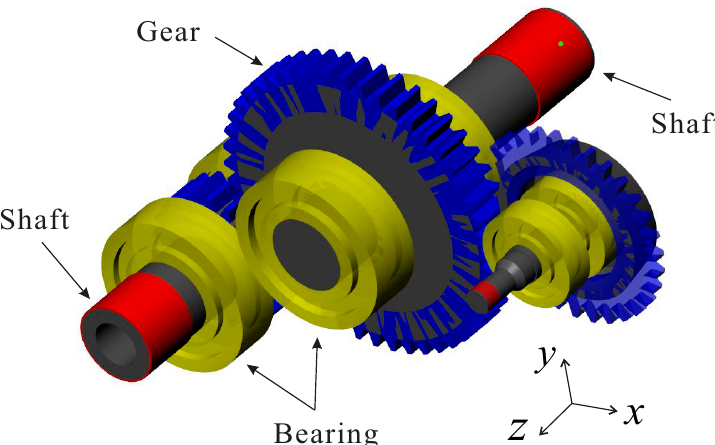
Figure 5. A two-stage parallel